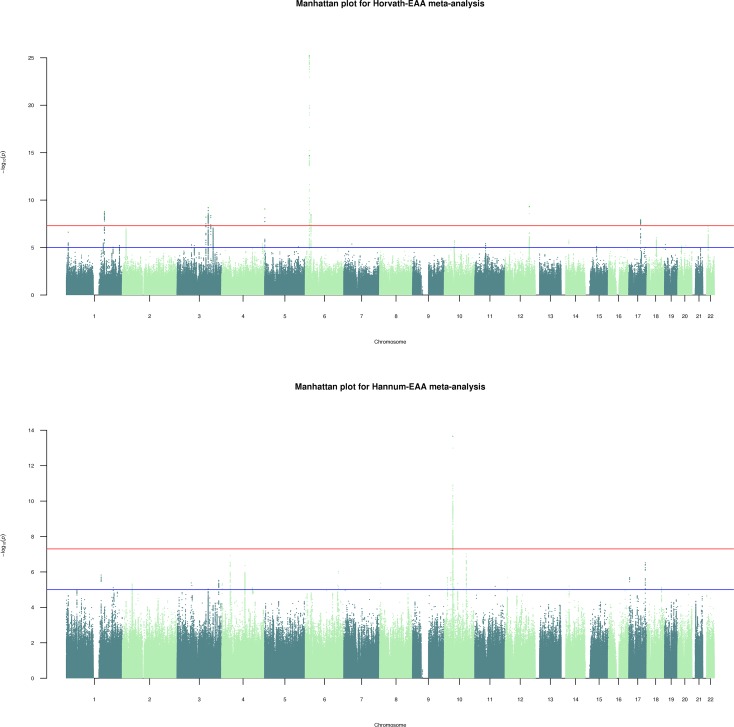
Manhattan plots for genome-wide meta-analyses (n = 13,493) of Horvath-based and Hannum-based epigenetic age acceleration.SNP-based Manhattan plots for Horvath-EAA and Hannum-EAA, with—log10 transformed P-values for each SNP plotted against chromosomal location. The red line indicates the threshold for genome-wide significance (P<5×10−8) and the blue line for suggestive associations (P<1×10−5). Independent significant variants are annotated.